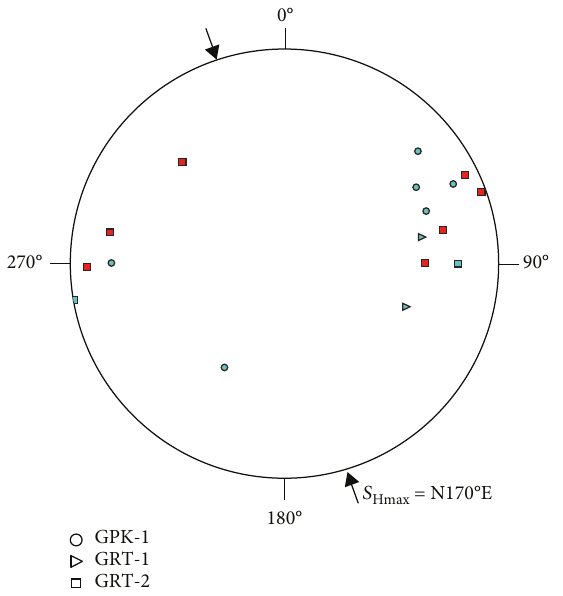
Figure 6: Stereoplot of the permeable fractures identi fi ed in acoustic image logs from GPK-1 (circle), GRT-1 (triangle), and GRT-2 (square). Blue symbols indicate fractures associated with negative anomalies, and red symbols indicate positive anomalies. Orientations and dips are detailed in Table 1. The maximum horizontal stress is from [56] for Soultz and from [57] for Rittersho ff